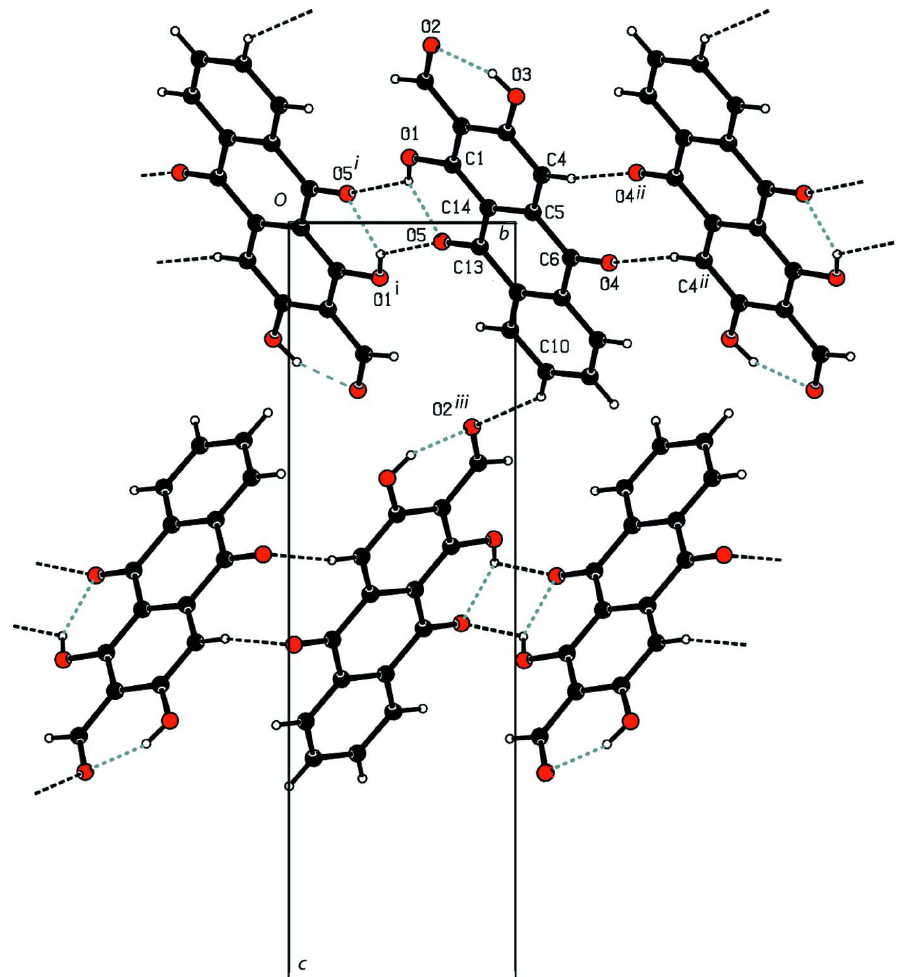
Figure 2 Part of the crystal structure showing non-parallel molecular slabs forming herringbone pattern along a . (Intra-)Inter- molecular hydrogen bonds are indicated by (dotted) dashed lines. Symmetry codes: as in Table